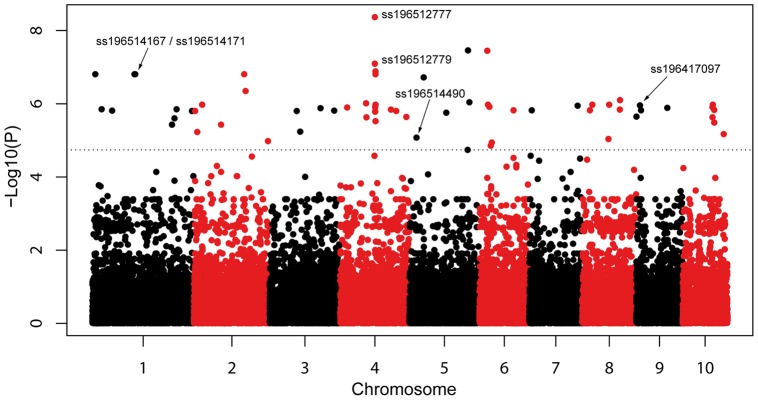
SNP associations with maximum temperature during growing season.Manhattan plot of the log10P-values for 43,963 SNPs along the chromosomes (Y-axis) for association with maximum temperature during the growing season. Dotted line indicates significance at 1% false discovery rate (FDR) threshold. Highlighted SNPs are described specifically in the main text.